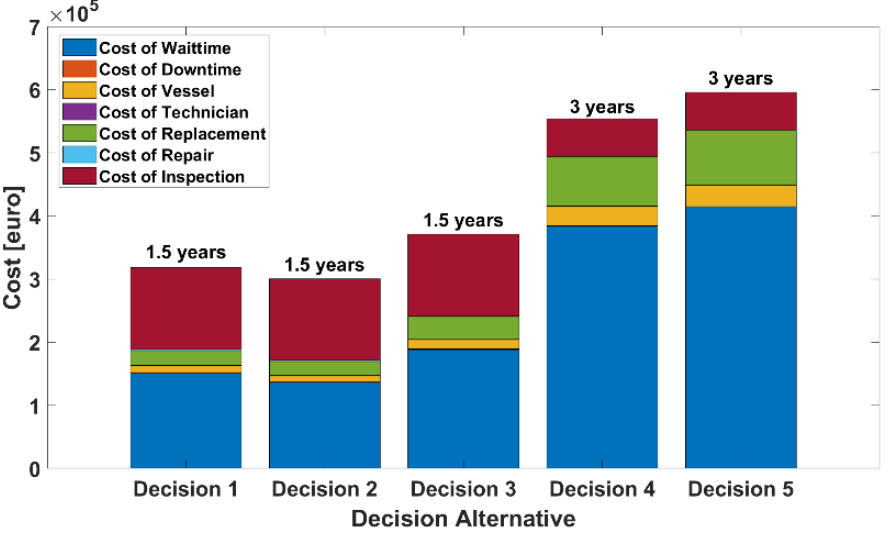
Figure 6. The total maintenance cost for different decision alternatives.